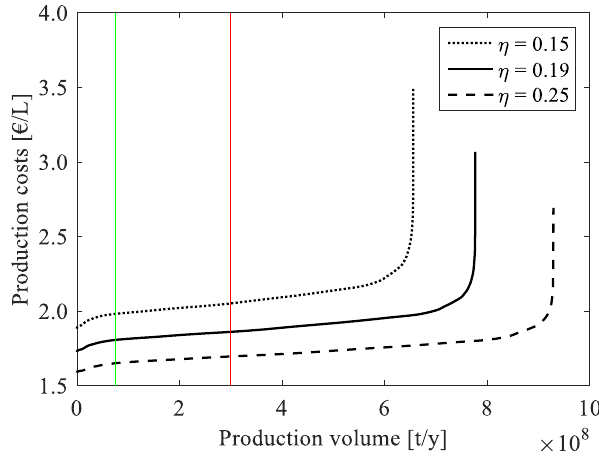
Figure A2. The cost-supply curve of solar thermochemical jet fuel for the USA with current US jet fuel demand [94] ( green line ) and world jet fuel demand [92] ( red line ).